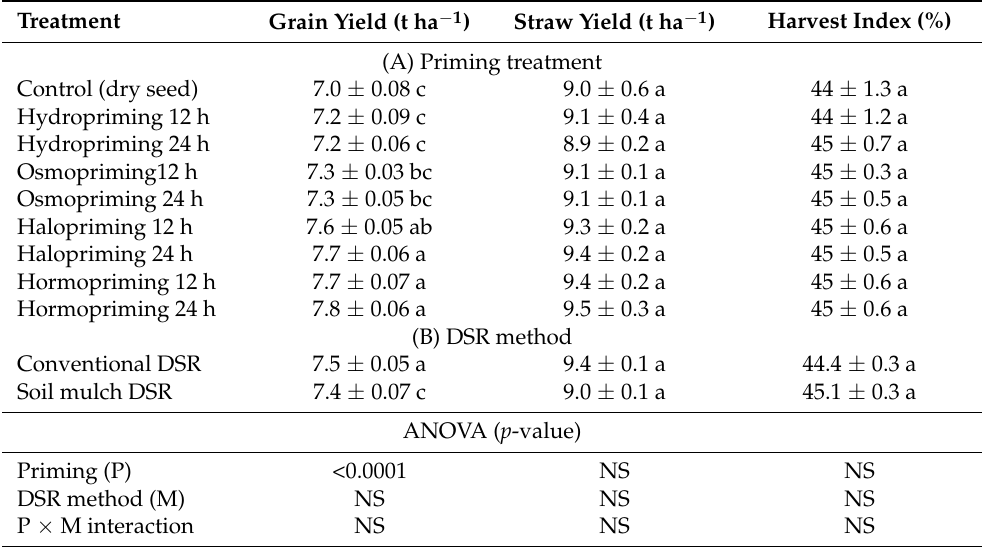
Table 13. Grain yield, straw yield and harvest index of DSR as affected by different seed priming and DSR establishment methods during 2019 at Ludhiana,